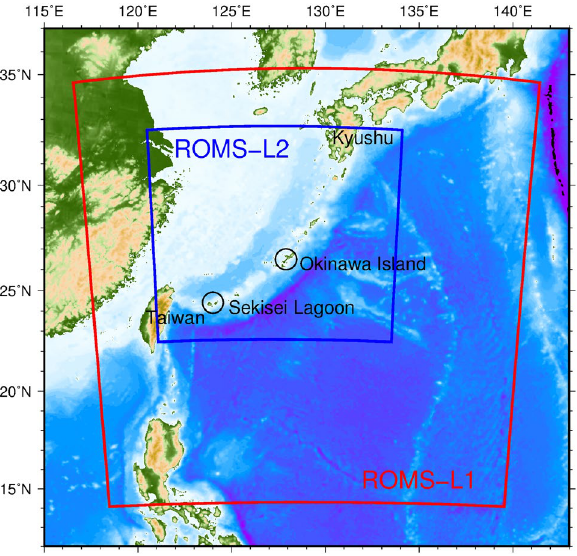
Figure 1. Model domains for ROMS-L1 (red) and ROMS-L2 (blue). Colors indicate bathymetry.